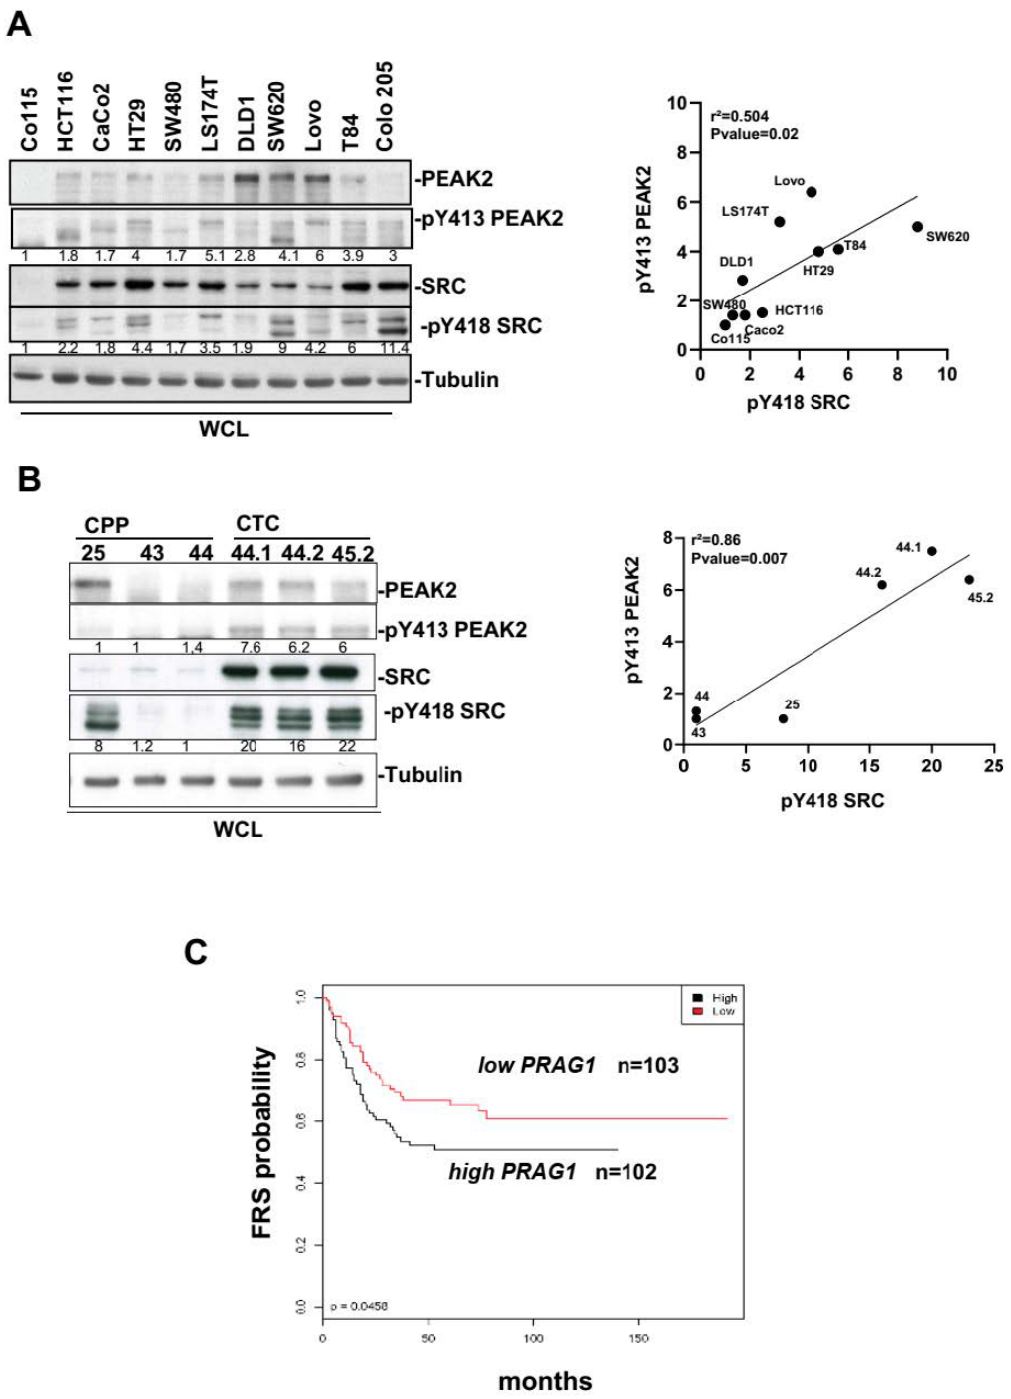
Figure 1. PEAK2 expression and tyrosine phosphorylation in CRC. ( A , B ): PEAK2 protein levels and Y413 phosphorylation in established CRC cell lines ( A ) and patient-derived CRC lines ( B ). Left panel: Western blotting showing the levels of PEAK2, pY413 PEAK2, SRC, and pY418 SRC from indicated CRC cell lines and CRC patient-derived lines. Right: correlation between the mean ( n = 3) of relative pY413 PEAK2 level (fold control) and relative SKF activity (pY418 SRC level, fold control) from indicated CRC or CTC cells. ( C ) Patients with CRC showing high PRAG1 expression have shorter free recurrence survival (FRS). Kaplan–Meier analysis using data from 205 patients with stage III CRC subdivided according to the tumour PRAG1 expression level (high/low) ( p -value: